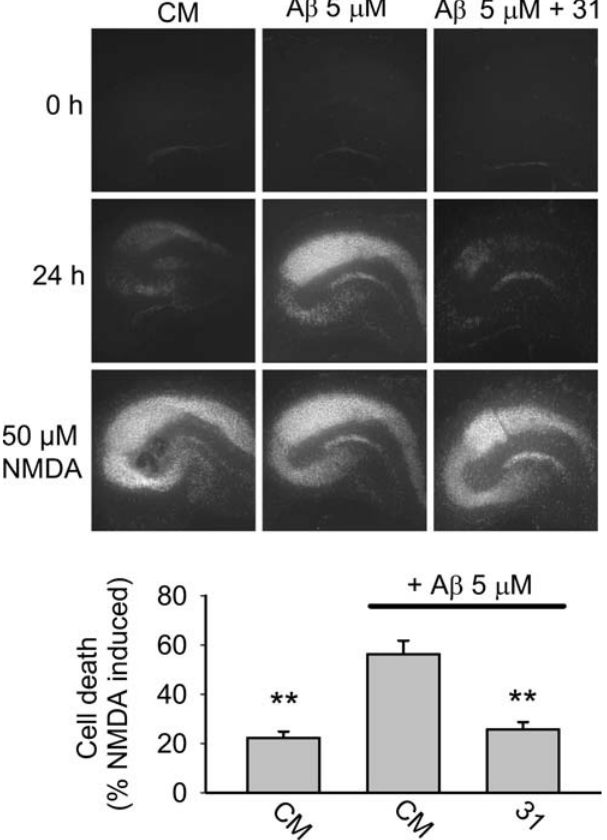
Figure 3. LM11A-31 inhibits A b -induced death of hippocampal neurons in postnatal organotypic slice cultures. Organotypic slice cultures were prepared from PND-8 rat brain and allowed to mature in vitro for 11–19 days. Pyramidal neuron death was detected by propidium iodide (PI) staining, and all experimental conditions were compared to A b treatment alone. Upper row , at baseline only trace levels of PI staining were detected. Middle row , PI staining after a 24 hour exposure to either culture medium (CM), A b or A b + LM11A-31 at 100 nM demonstrates readily apparent A b -induced pyramidal neuron death that is inhibited in the presence of p75 NTR ligand. Bottom row , PI staining shows maximum neuronal death after 24 hour treatment with NMDA. In the lower panel, quantitative analysis of PI staining demonstrates a significant reduction in A b -induced neuronal death (n=56–59 brain slices derived from 4 independent studies).